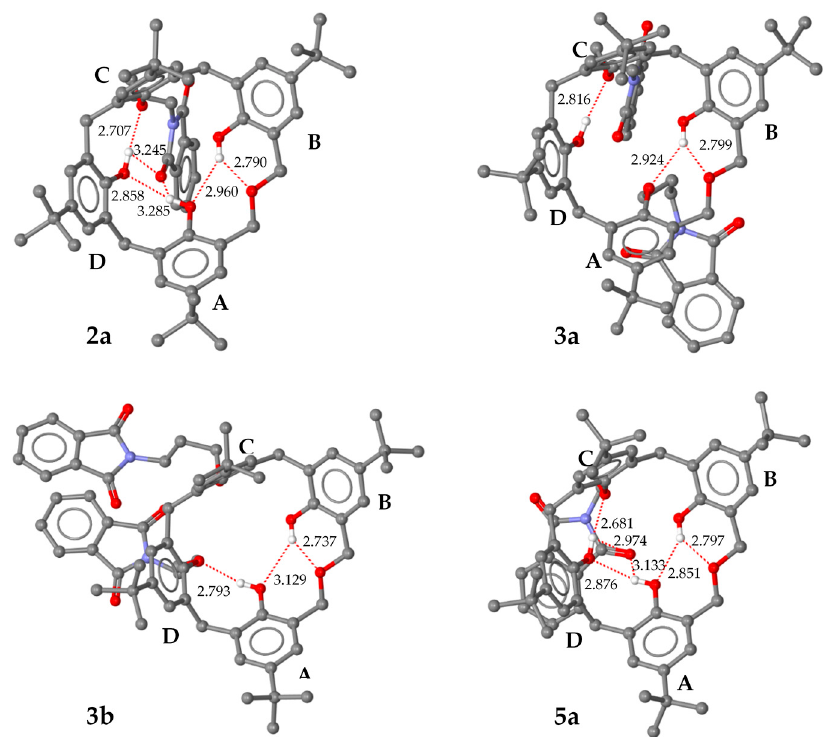
Figure 5. Comparison of the intramolecular hydrogen bonds in 2a , 3a , 3b and 5a . Only one of the crystallographically independent molecules is shown for 2a (4 molecules in the asymmetric unit) and for 3a (3 molecules in the asymmetric unit). The atomic species are represented in CPK colors. Ellipsoids are drawn at 50% probability, except for 5a , in which the ellipsoids are represented at 30% probability. Hydrogen atoms, atom disorder and solvent molecules are omitted for clarity.